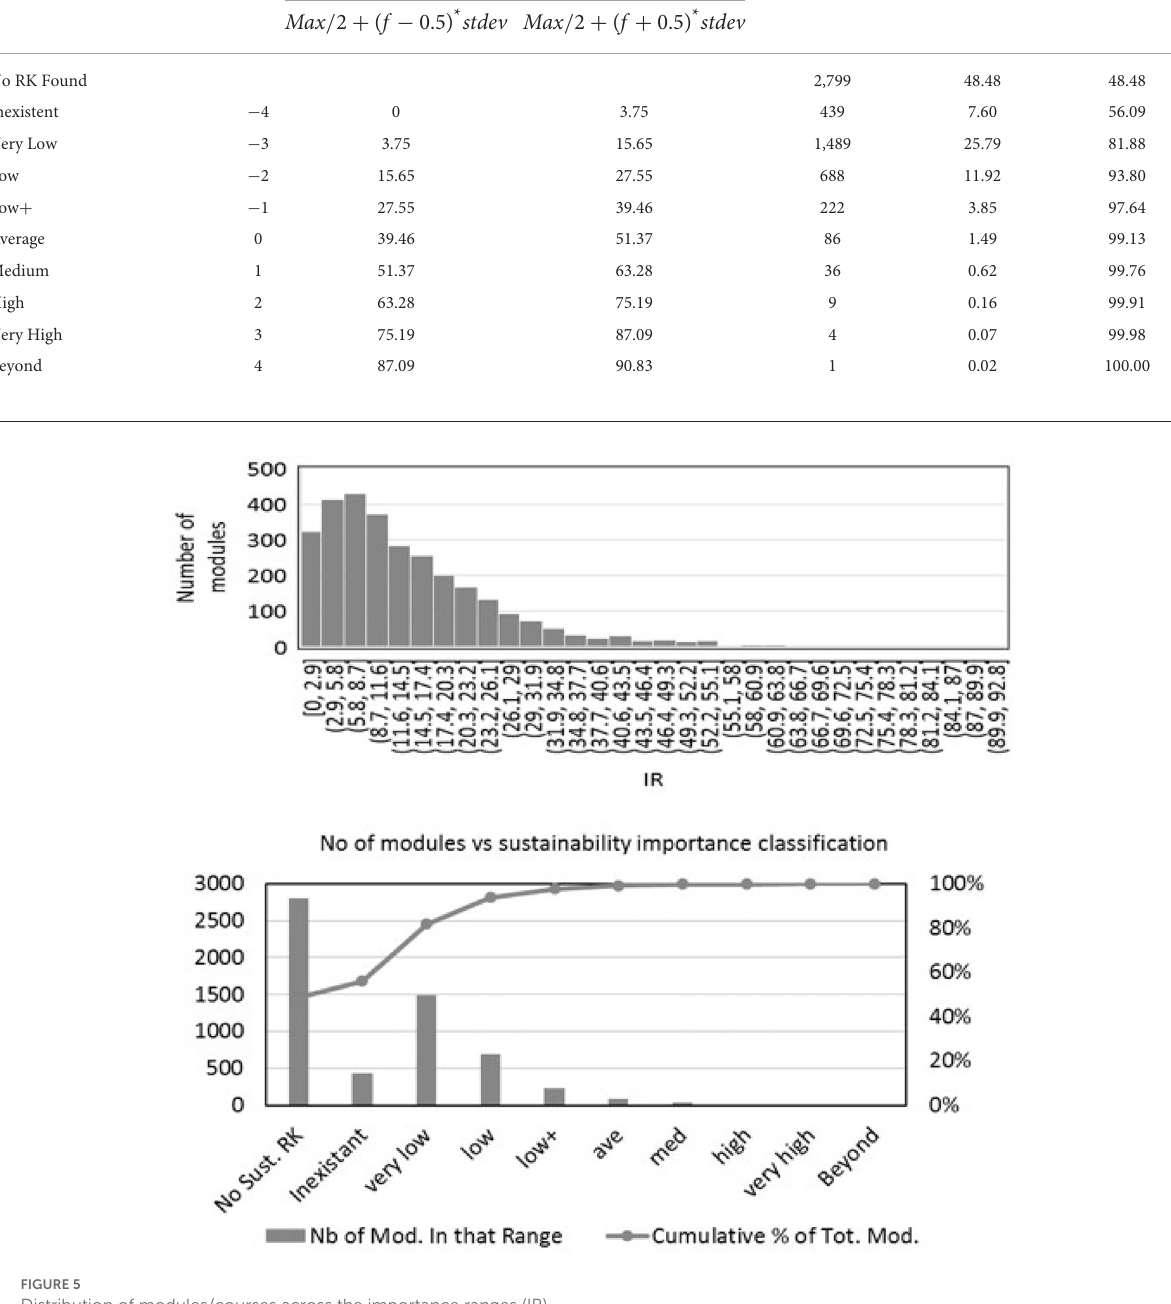
TABLE 3 Categorization of module sustainability importance by importance range (IR).